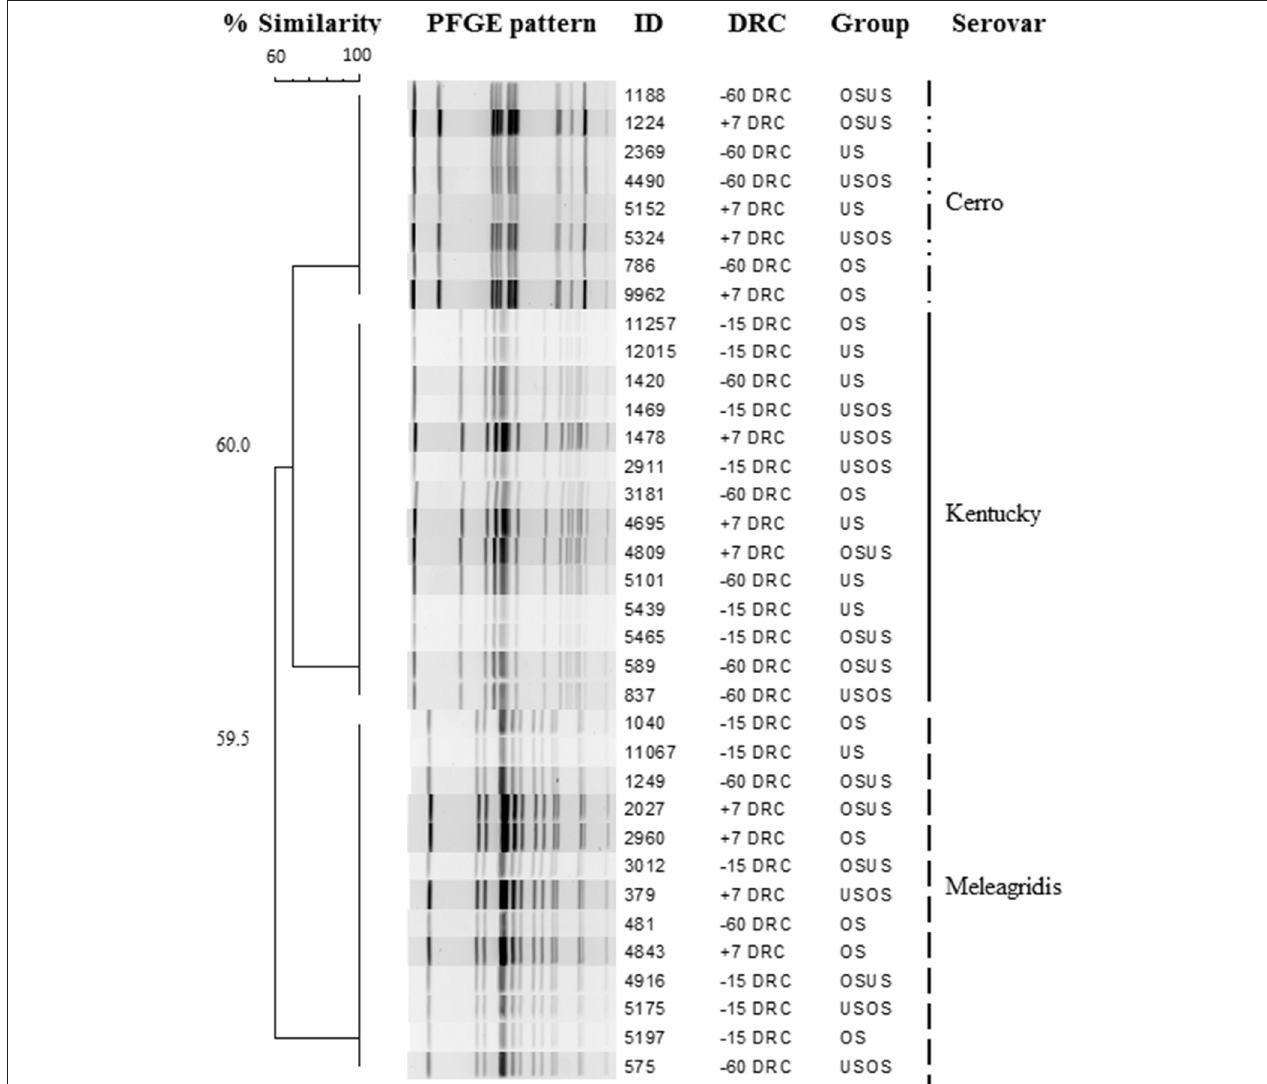
FIGURE 2 | Dendrogram showing pulsed field electrophoresis profiles of Salmonella isolates recovered from periparturient cows according to days relative to calving (DRC) and treatment group. Three serotypes were identified among isolates.